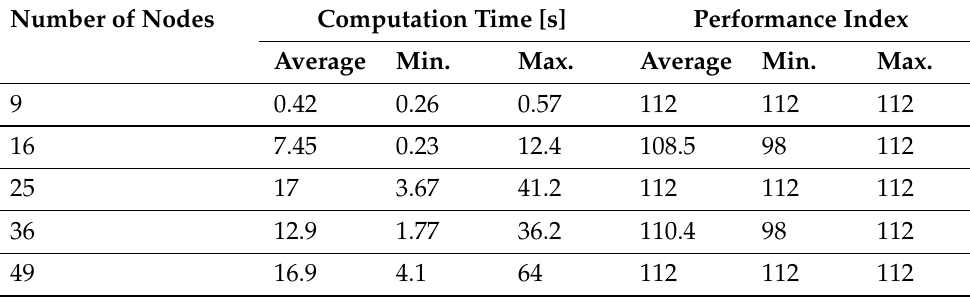
Table 7. Results for algorithm using maximal energy consumption index.